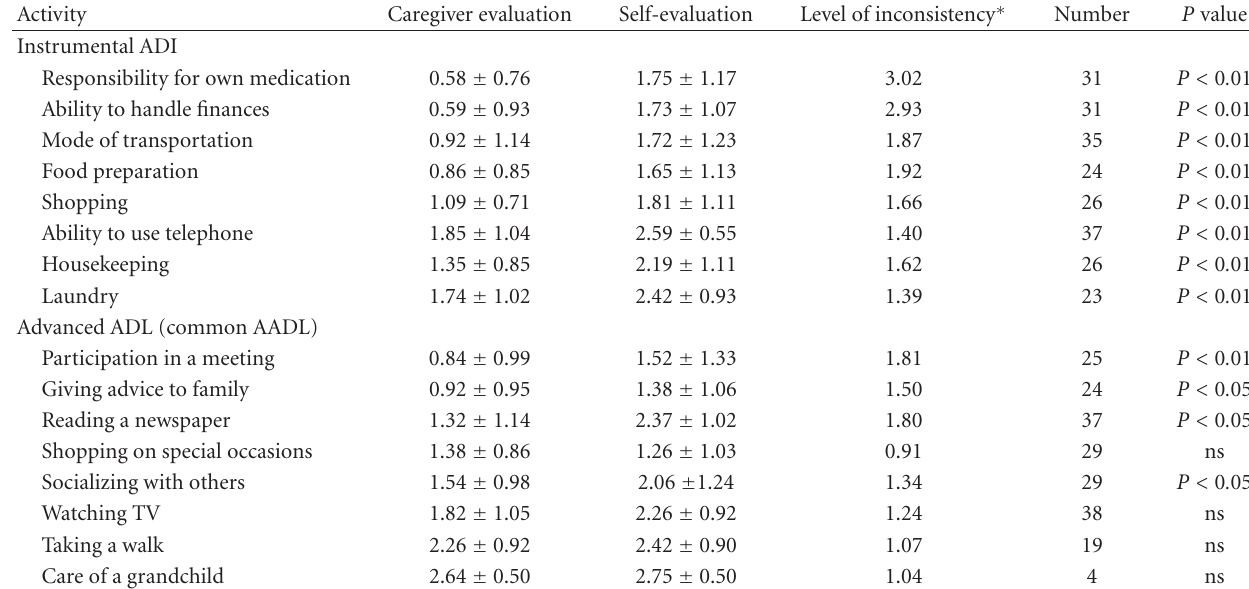
Table 3: Di ff erence of present activities of daily living (ADL) evaluated by patients and